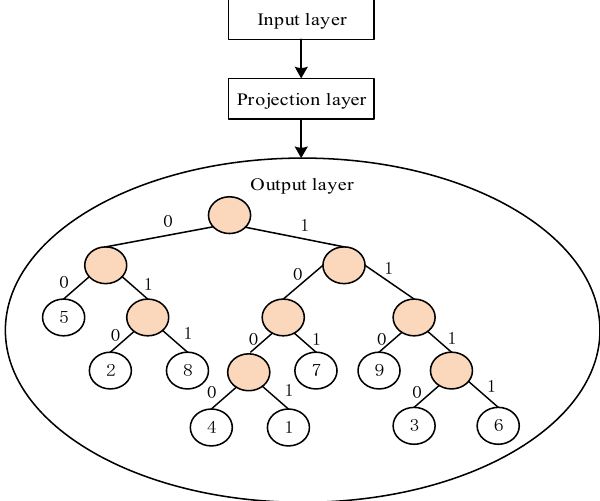
Figure 2. Structure of training truck drivers’ braking behavior words.